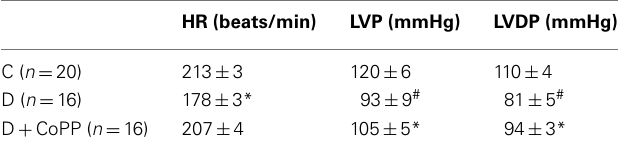
Table 1 | Hemodynamic parameters in control rats (C, n = 20), diabetic rats (D, n = 16), and diabetic rats treated for 3weeks with CoPP (D + CoPP, n = 16).